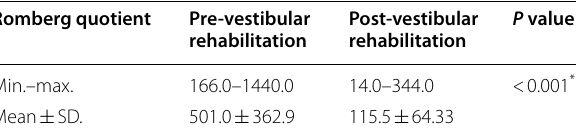
Table 9 Vestibular stimulation test with sagittal head movement before and after vestibular rehabilitation